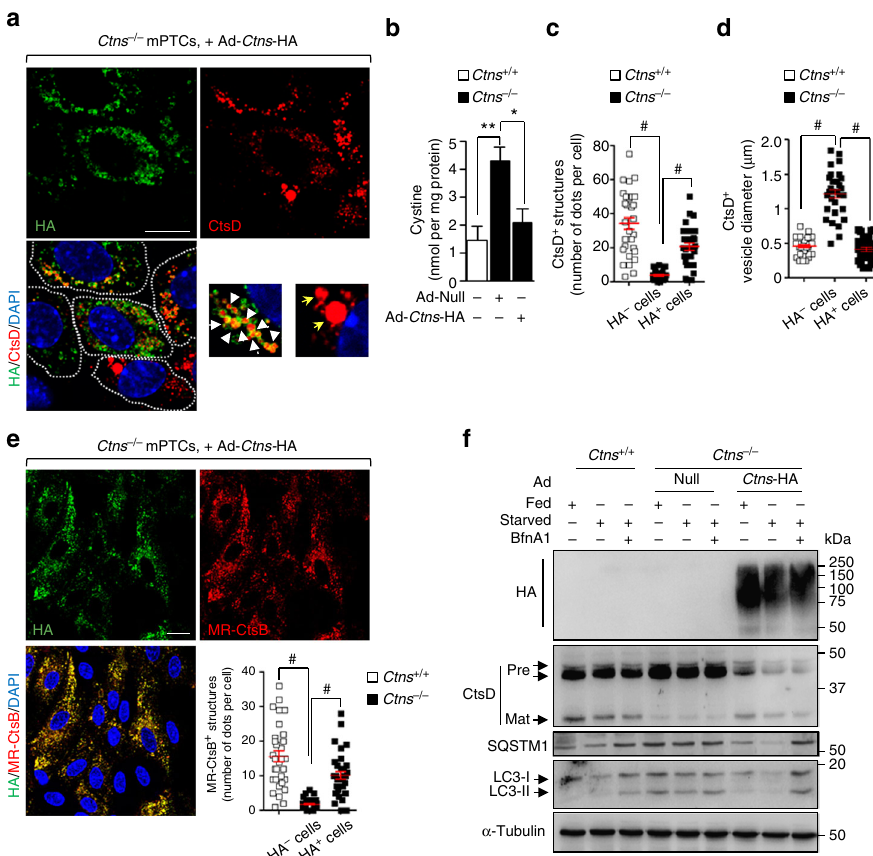
Fig. 4 Rescue of lysosome – autophagy pathway by re-expressing CTNS in Ctns − / − cells. a – f Ctns − / − mPTCs were transduced with either Null (Ad-Null) or hemagglutinin-tagged Ctns (Ad- Ctns -HA) bearing adenoviral particles for 2 days. a Cells were immunostained with anti-HA (green) and anti-CtsD (red) antibodies, and analysed by confocal microscopy. Insets: high magni fi cation of Ctns- HA + vesicles containing CtsD. b Intracellular cystine levels were measured by HPLC. Two-tailed unpaired Student ’ s t -test, ** P < 0.01 relative to Ctns + / + mPTCs; * P < 0.05 relative to Ctns − / − mPTCs transduced with Ad- Null. c Quanti fi cation of changes in the number of CtsD + and d in the average vesicle size in cells from a ( n = 30 cells pooled from three Ctns kidneys per condition; each point representing the number or the average size of CtsD + vesicles in a cell; one-way ANOVA followed by Bonferroni ’ s post hoc test, # P < 0.0001 relative to Ctns + / + mPTCs or to HA − Ctns − / − mPTCs. e Ctns mPTCs were loaded with MR-CtsB peptide (1 μ M, for 1 h at 37 °C) and immunostained with anti-HA antibody. Quanti fi cation of numbers of MR-CtsB + structures ( n = 33 cells pooled from three Ctns kidneys per condition, each point representing the number of MR-CtsB + vesicles in a cell; one-way ANOVA followed by Bonferroni post hoc test, # P < 0.0001 relative to Ctns + / + mPTCs or to HA − Ctns − / − mPTCs). f Ctns mPTCs were cultured in fed or starved medium in presence or in absence of 250nM BfnA1 for 4 h. The cells were lysed and subjected to western blotting analysis for the protein levels of HA, CtsD, SQSTM1, and LC3. α -Tubulin was used as a loading control, n = 3 independent experiments. Plotted data represent mean ± SEM. The nuclei are counterstained with DAPI (blue). Yellow indicates colocalization. Scale bars are 10 μ